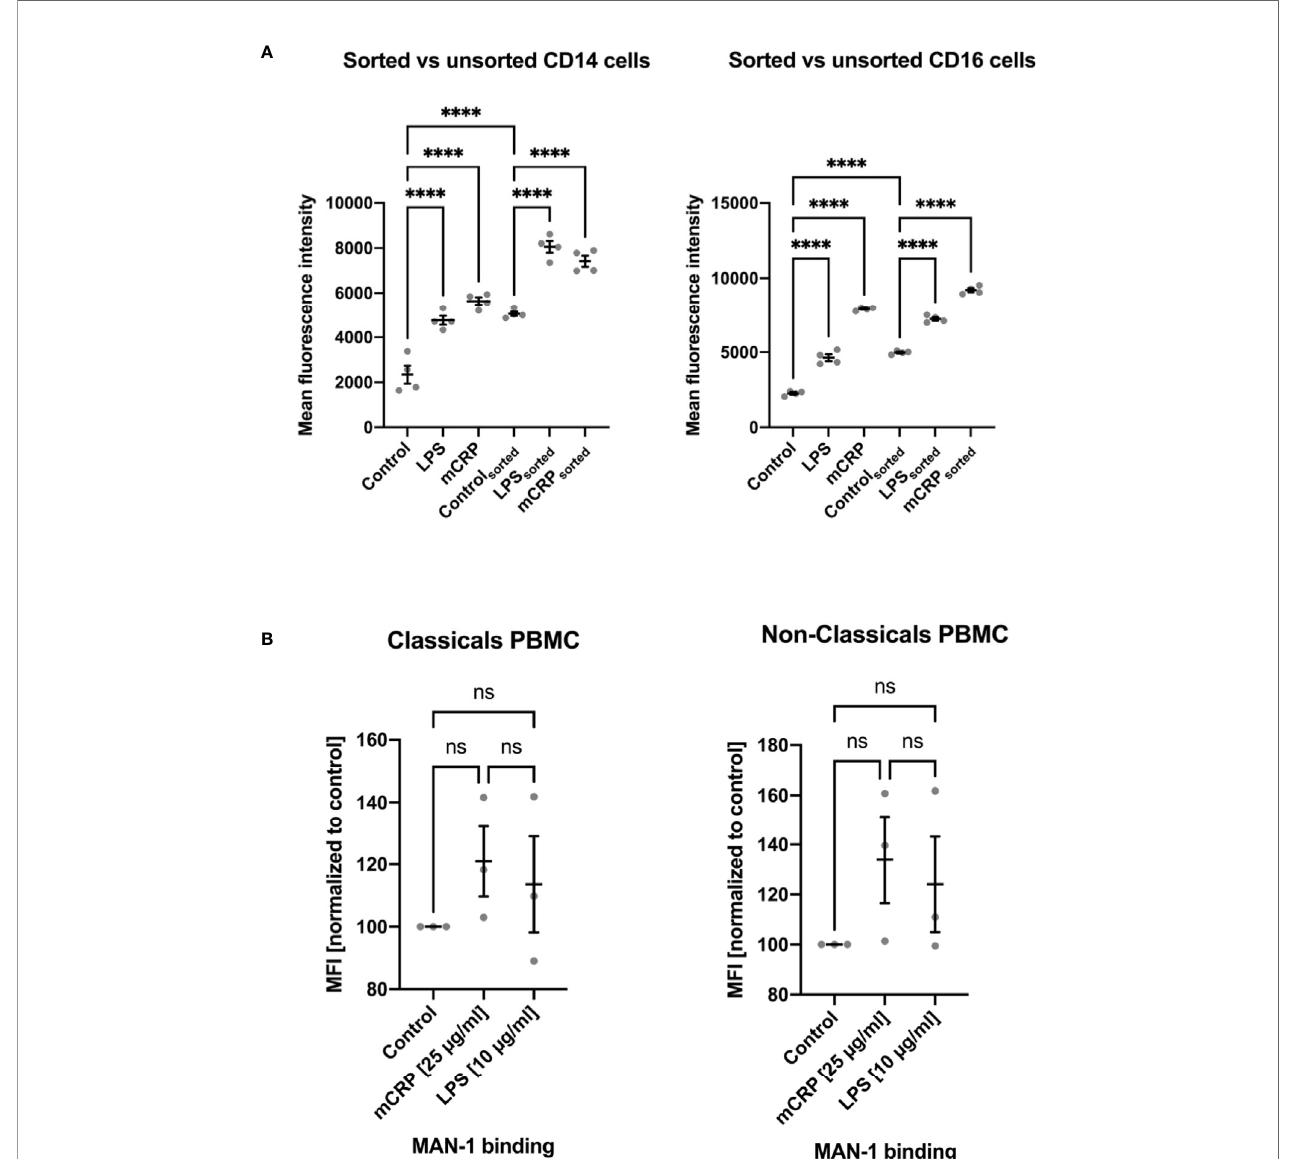
FIGURE 5 | Comparison of monocyte activation state in whole blood samples upon stimulation with PBS (control), mCRP, and LPS to activation states assessed after cell isolation via fl uorescence-activated cell sorting ( FACS; A) and density gradient centrifugation (PBMC; B). An increase in MAN-1 expression demonstrated cell activation. The MFI for MAN-1 of the respective control sample was set as 100. Both monocyte subtypes showed a marked upregulation of MAN-1 after cell isolation itself, especially following density gradient centrifugation (B) . While FACS led to a moderate increase in cell activity, allowing the evaluation of monocytes ’ activation state upon further stimulation (A) , PBMC isolation resulted in an out of scale pre-activation of the cells that rendered further stimulation insigni fi cant (B) . ns, not signi fi cant; ****p <